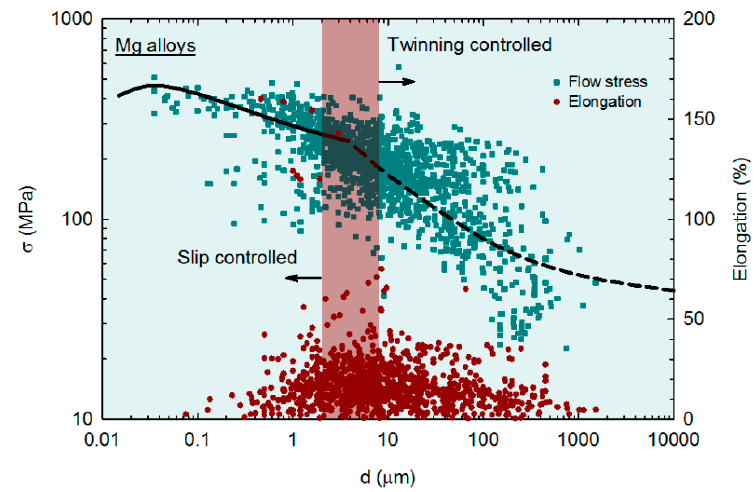
Figure 8. Flow stress and elongation in tension of multiple magnesium alloys plotted as a function of the grain size [44].